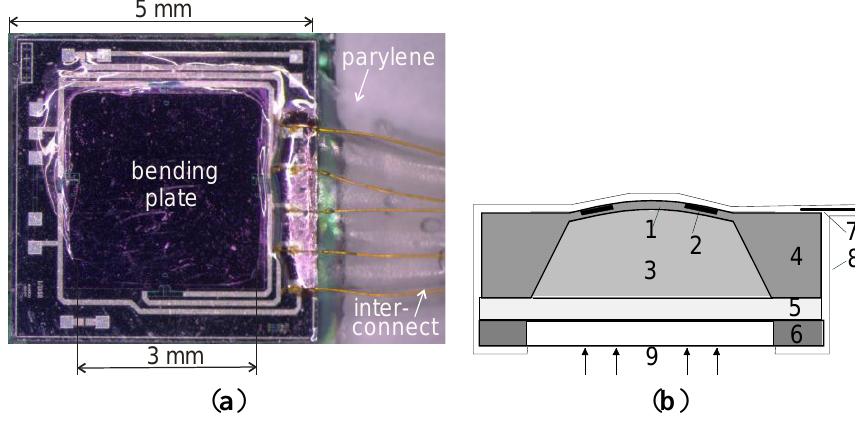
Figure 1. Hydrogel-based biochemical dip sensor: ( a ) frontside photograph of the sensor and ( b ) sensor design: 1 bending plate (3 mm × 3 mm × 0.02 mm), 2 mechano-electrical transducer (piezoresistive bridge), 3 swellable hydrogel, 4 Si chip (5 mm × 5 mm × 0.39